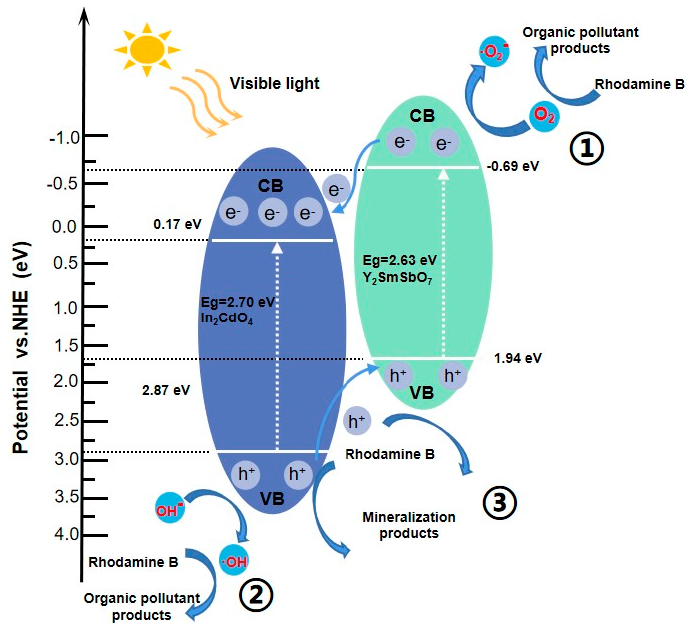
Figure 19. Possible PCD mechanism of RhB with In 2 CdO 4 /Y 2 SmSbO 7 nanocomposite as photocata- lyzer under visible light irradiation.